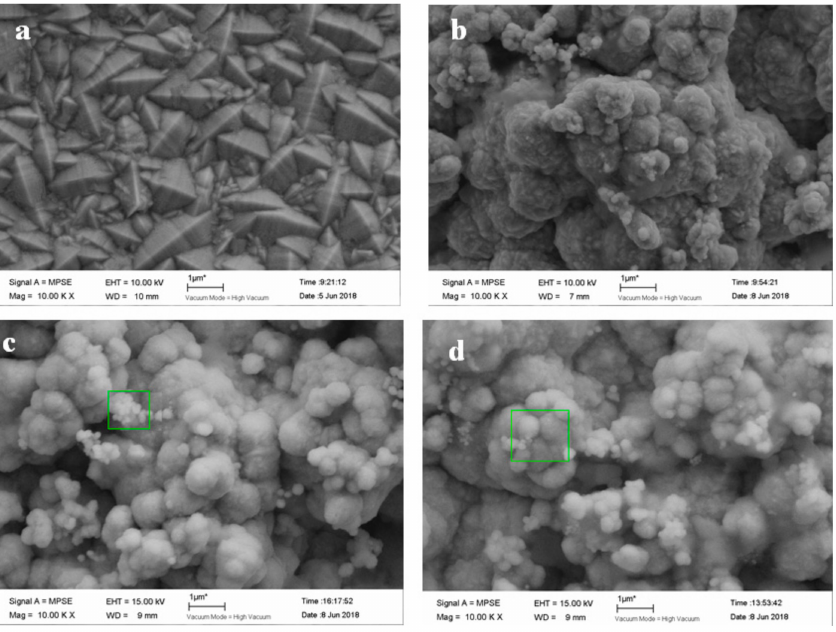
Figure 15. SEM images of coating prepared by di ff erent electroplating modes: ( a ) DC electroplating Ni coating, ( b ) single-pulse plating, ( c ) double-pulse electroplating with positive pulse operating time of 50 ms, and ( d ) double-pulse electroplating with positive pulse operating time of 100